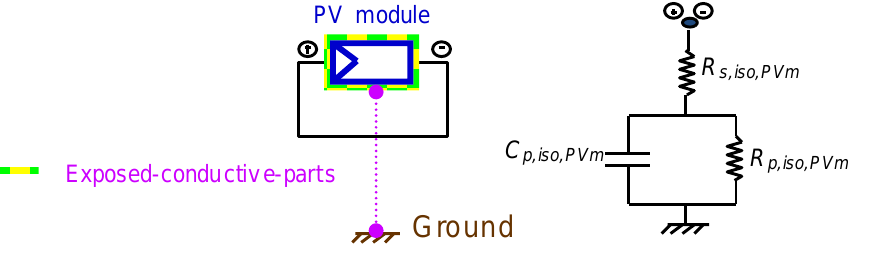
Figure 8. Equivalent circuit model for the insulation of a PV module [36].